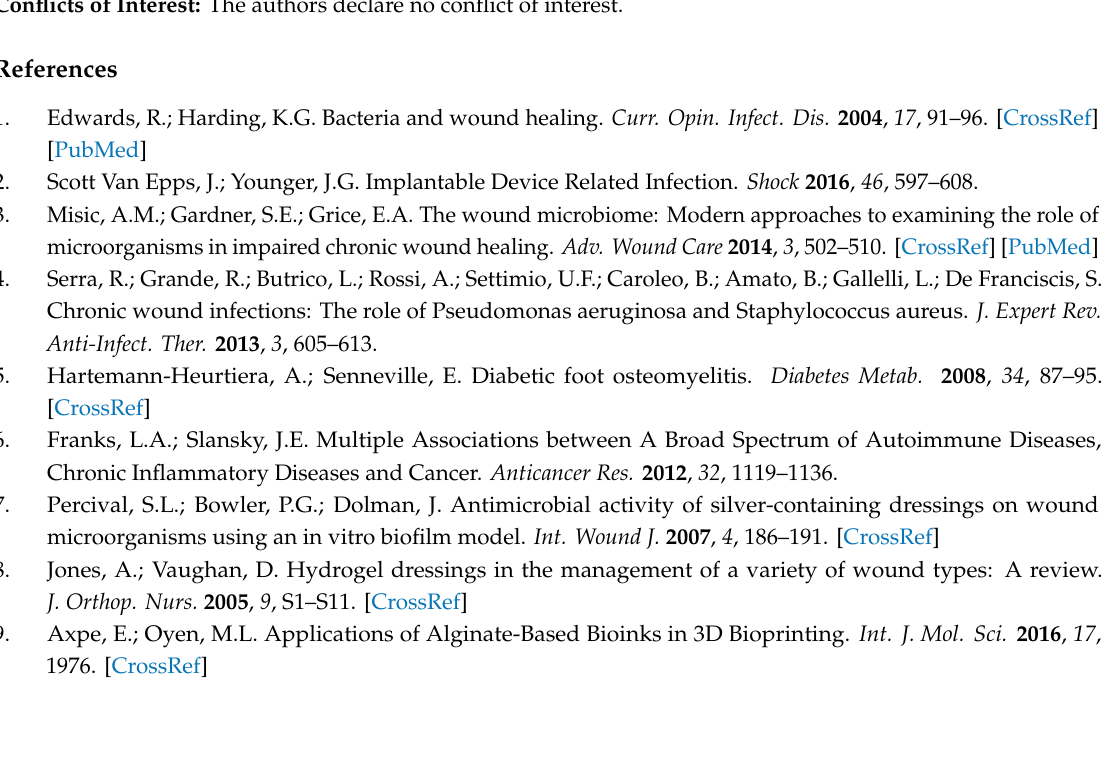
Table S1: List of peptides and SRM transitions monitored, Table S2: Bradford assay protein quantitation (n =